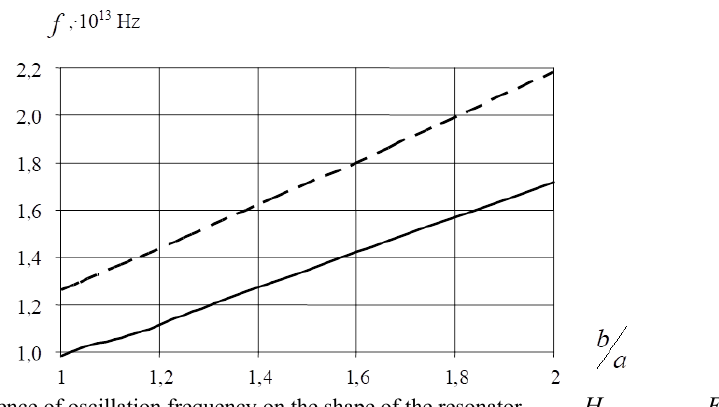
Fig. 3. Dependence of oscillation frequency on the shape of the resonator ––––